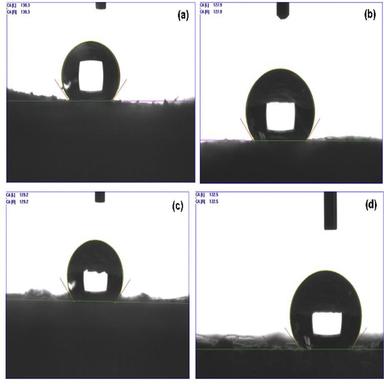
SEM images of QTZ/ARG, before 60Co exposure on fibre (a) and aerogel network (c) spots, and after 60Co exposure on fibre (b) and aerogel network (d) spots.